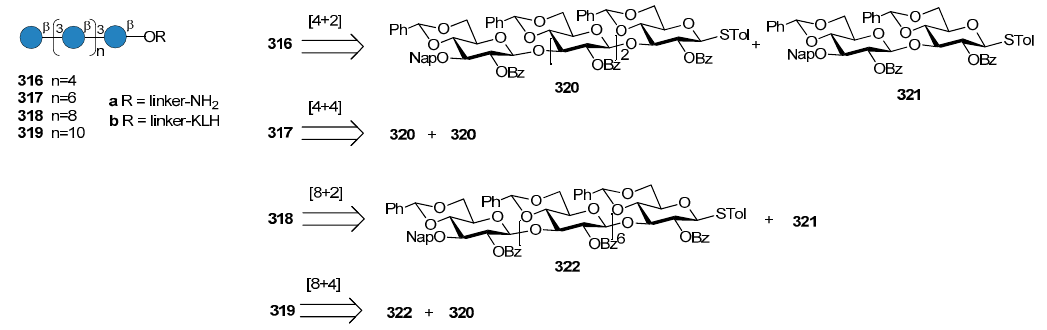
Figure 34. Hexa-, octa-, deca- and dodecasaccharide of β -glucan reported in Reference [248].